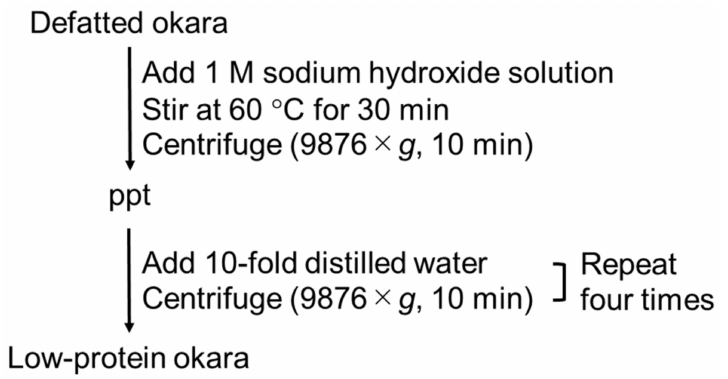
Figure 5. Schematic diagram for the preparation procedure of low-protein